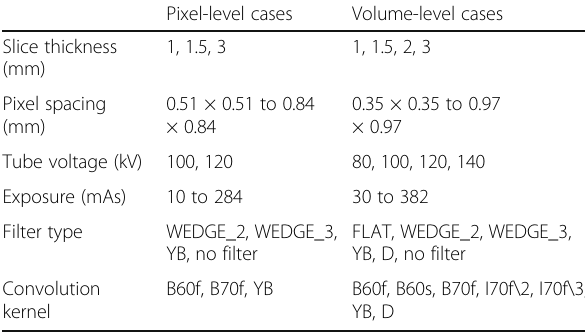
Table 1 Technical specifications for the pixel- and volume-level